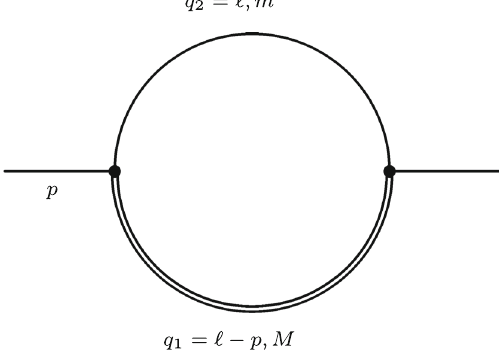
Fig. 1 Two-point function with internal masses M >